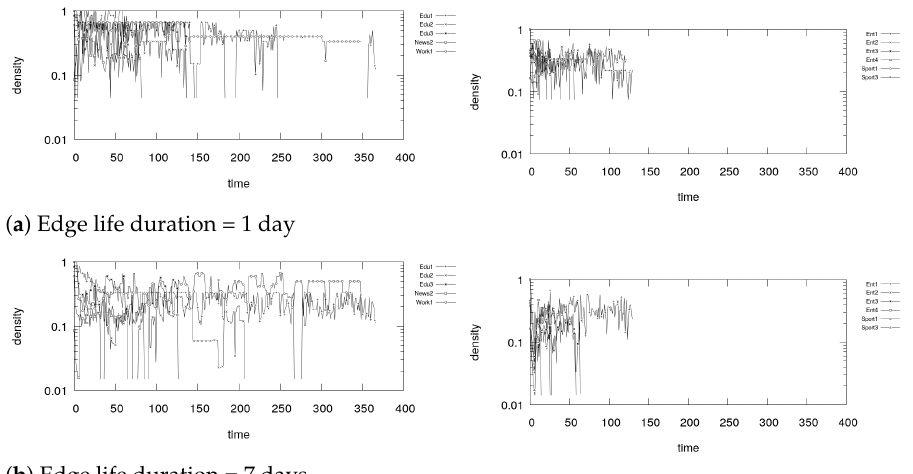
Figure 33. Internal density of communities detected by